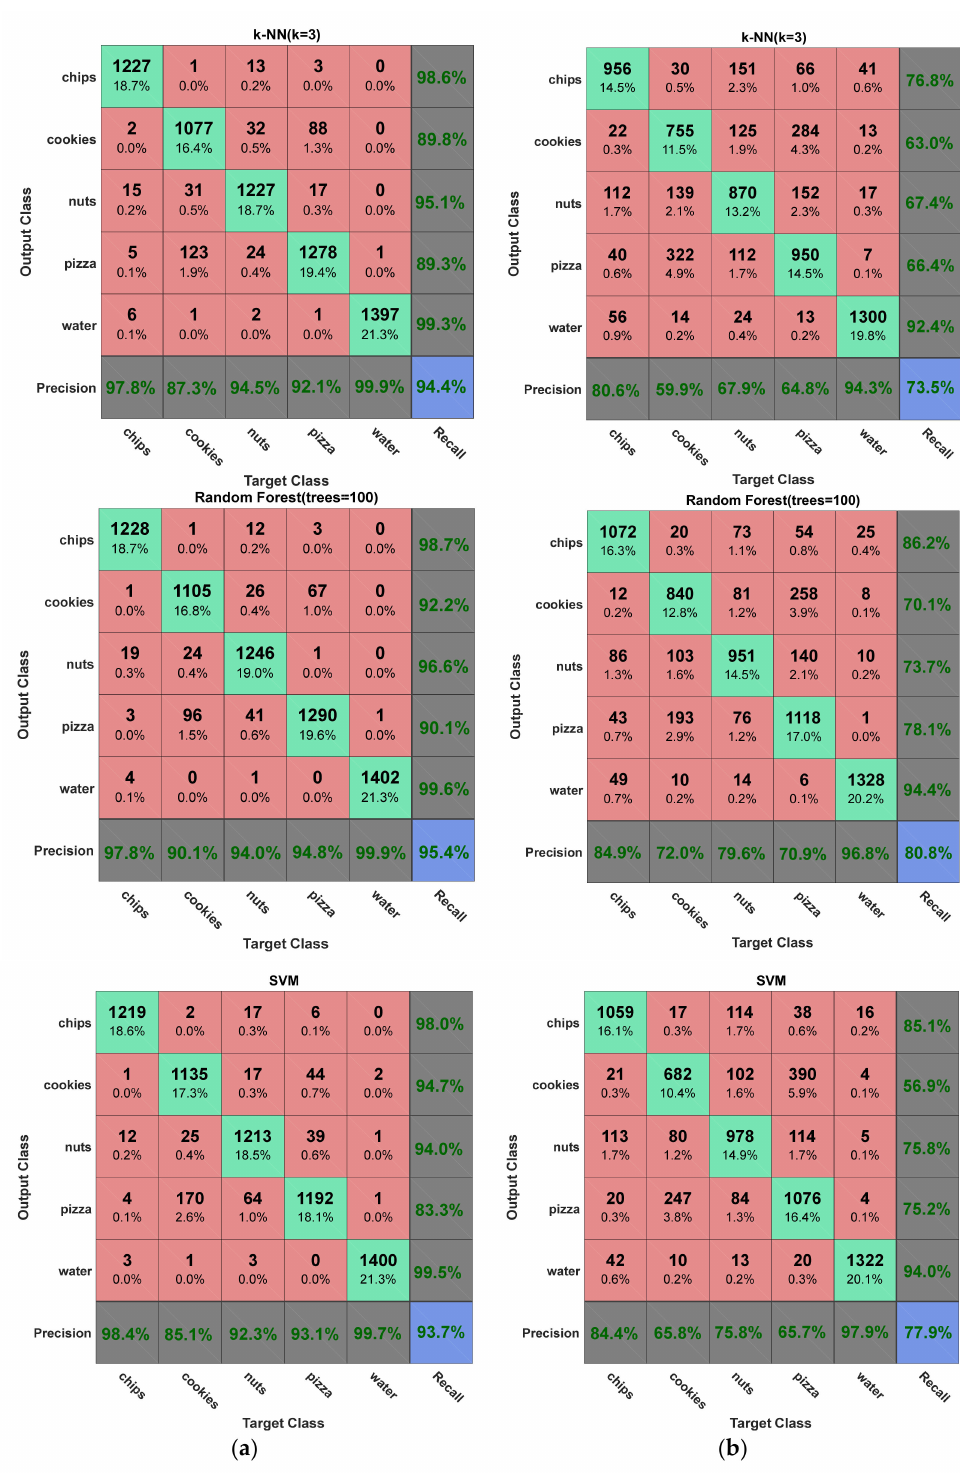
Figure 8. Food recognition performance: ( a ) Food recognition performance of the proposed method; ( b ) Food recognition performance of the previous